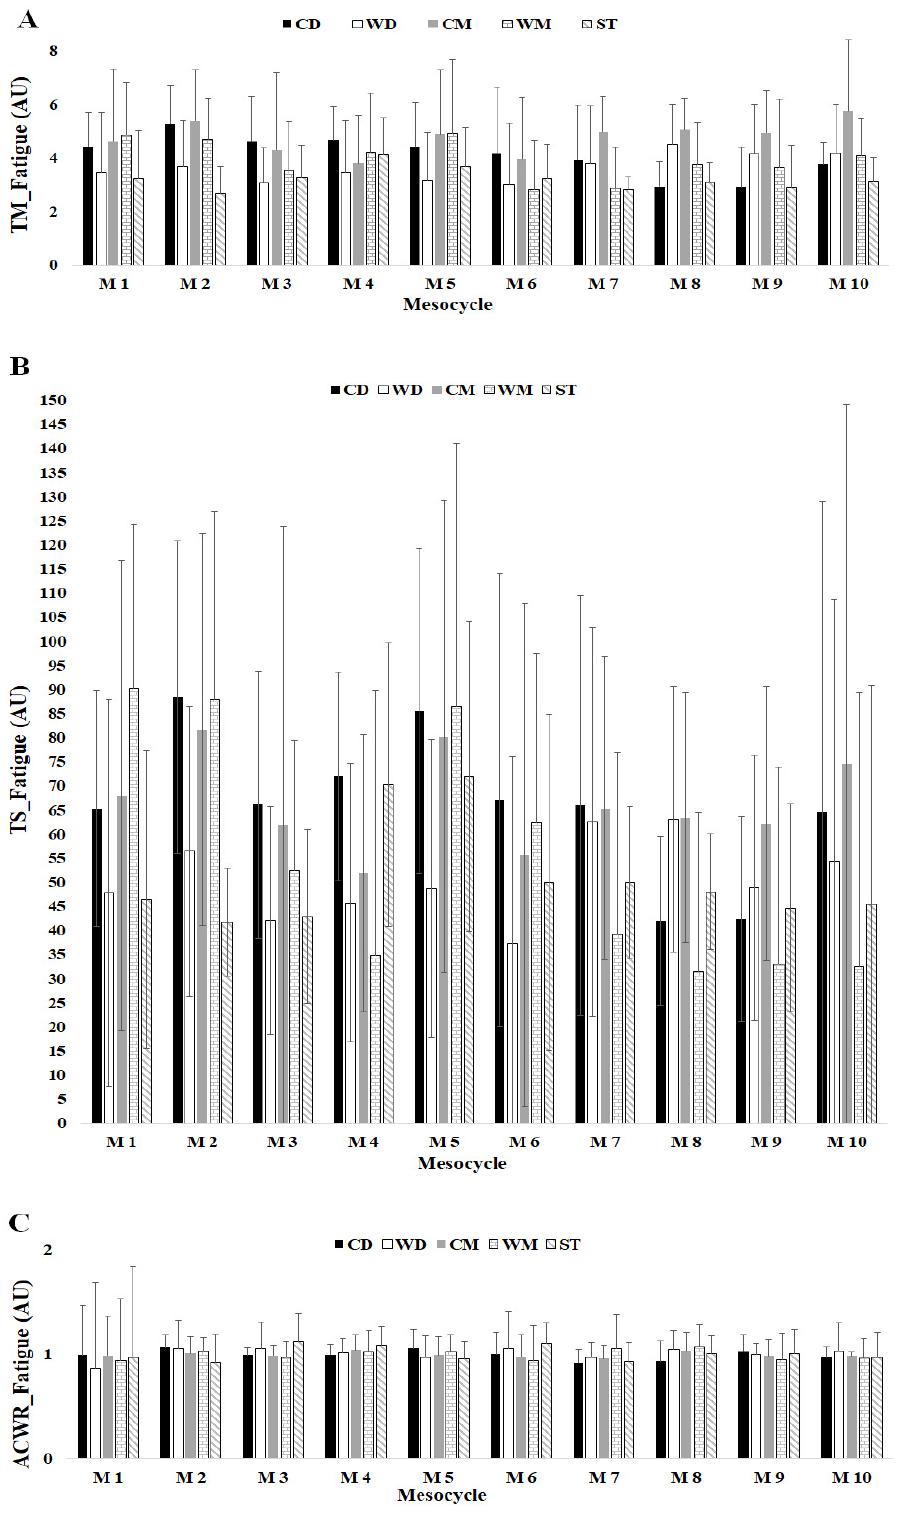
Fig. 3. Training Monotony (TM), Training Strain (TS) and Acute: Chronic Workload Ratio (ACWR) variations calculated through fatigue category across 10 mesocycles (M1-10) for player positions. (A) TM. (B) TS. (C) ACWR. CD, central defenders; WD, wide defenders; CM, central midfielders; WM, wide midfielders; ST,